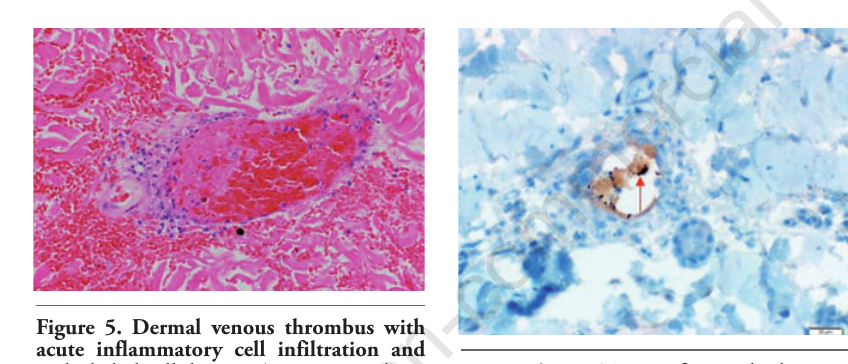
Figure 6. MRSA specific antibody stain demonstrating bacteria in a blood vessel.